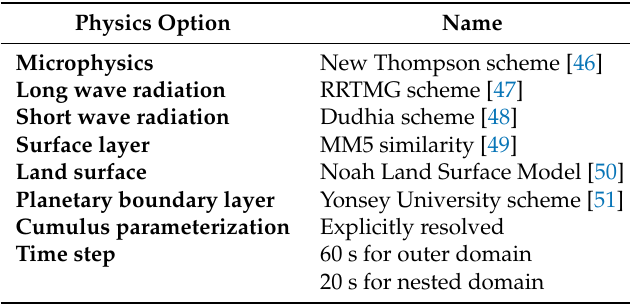
Table 2. Physics options used in WRF model configuration. Please see the WRF model user guide for further